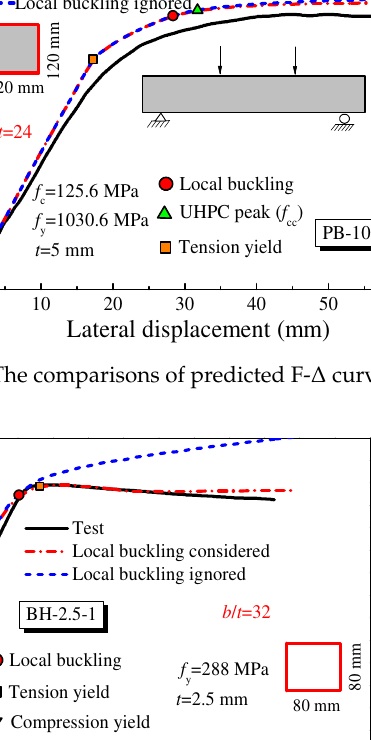
( b ) Figure 8. The comparisons of predicted N-Δ curves with test results (Zhang et al. [35]). ( a ) SS4-S-30 ( b ) SS4-S-50.